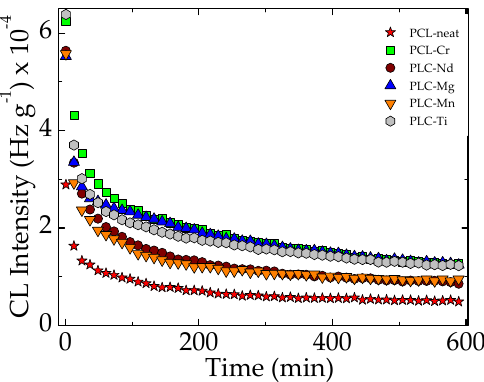
Figure 3. The isothermal CL spectra recorded on the pristine PCL-based samples containing PbZrO 3 doped with various metallic atoms. Testing temperature: 140 °C.